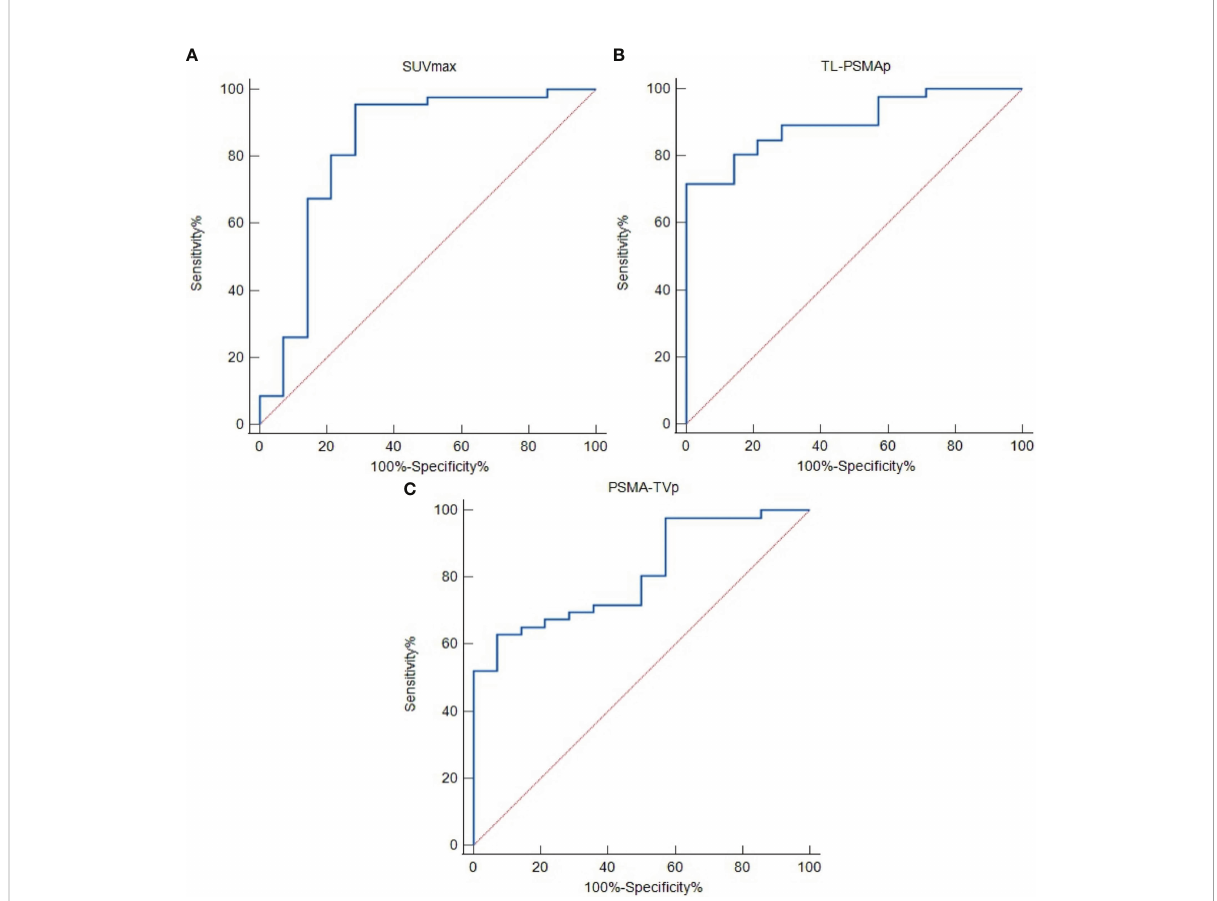
FIGURE 4 Receiver operating characteristic (ROC) curves to detect high-risk prostate cancer using semi-quantitative prostate-speci fi c membrane antigen (PSMA) PET parameters. (A) Maximum standardized uptake value (SUVmax). (B) Prostate total lesion PSMA (TL-PSMAp). (C) Prostate PSMA-tumor volume (PSMA-TVp).